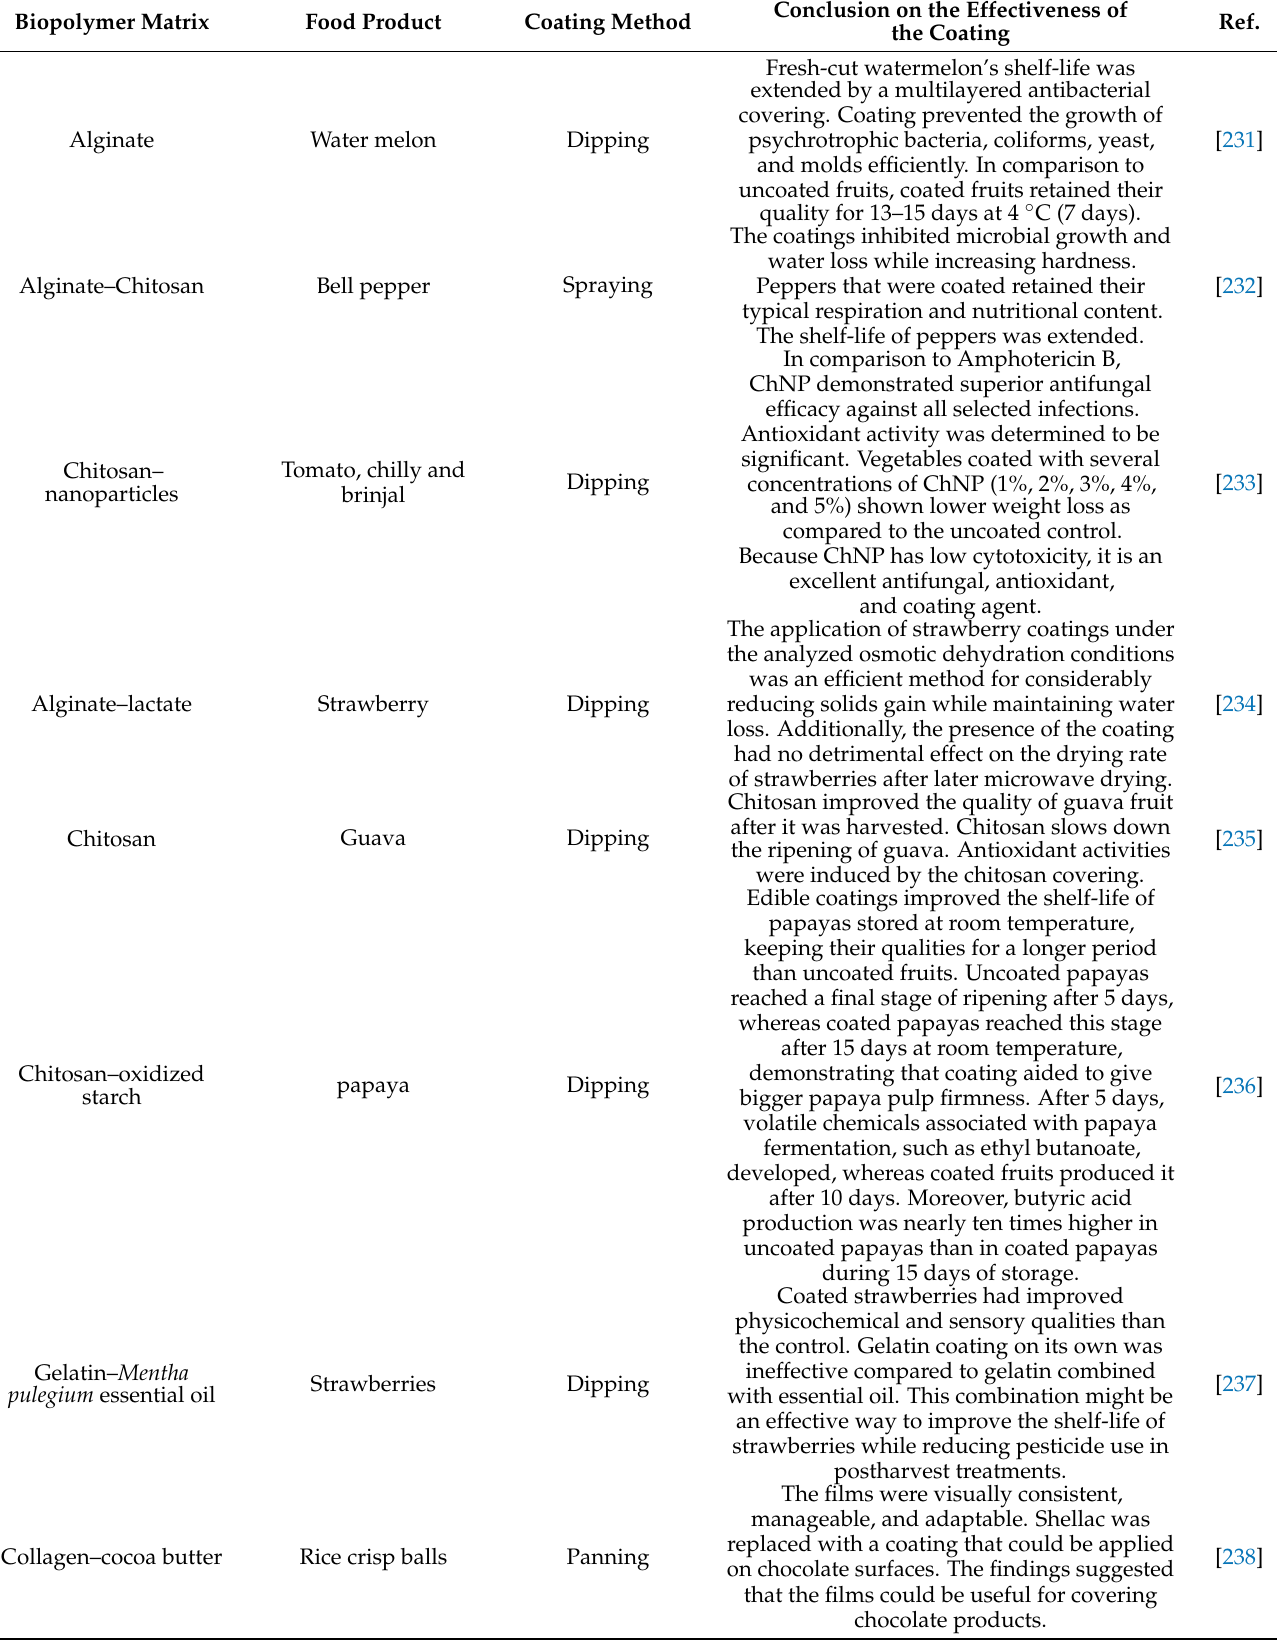
Table 3. List of application methods for edible coatings on food products prepared from marine